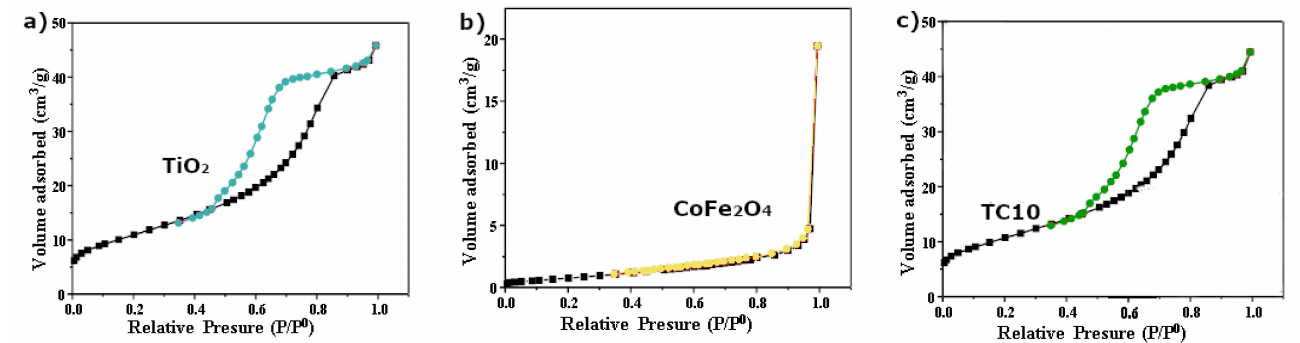
Figure 5. N 2 adsorption-desorption isotherm plot of TiO 2 ( a ), CoFe 2 O 4 ( b ) and TC10 ( c ).